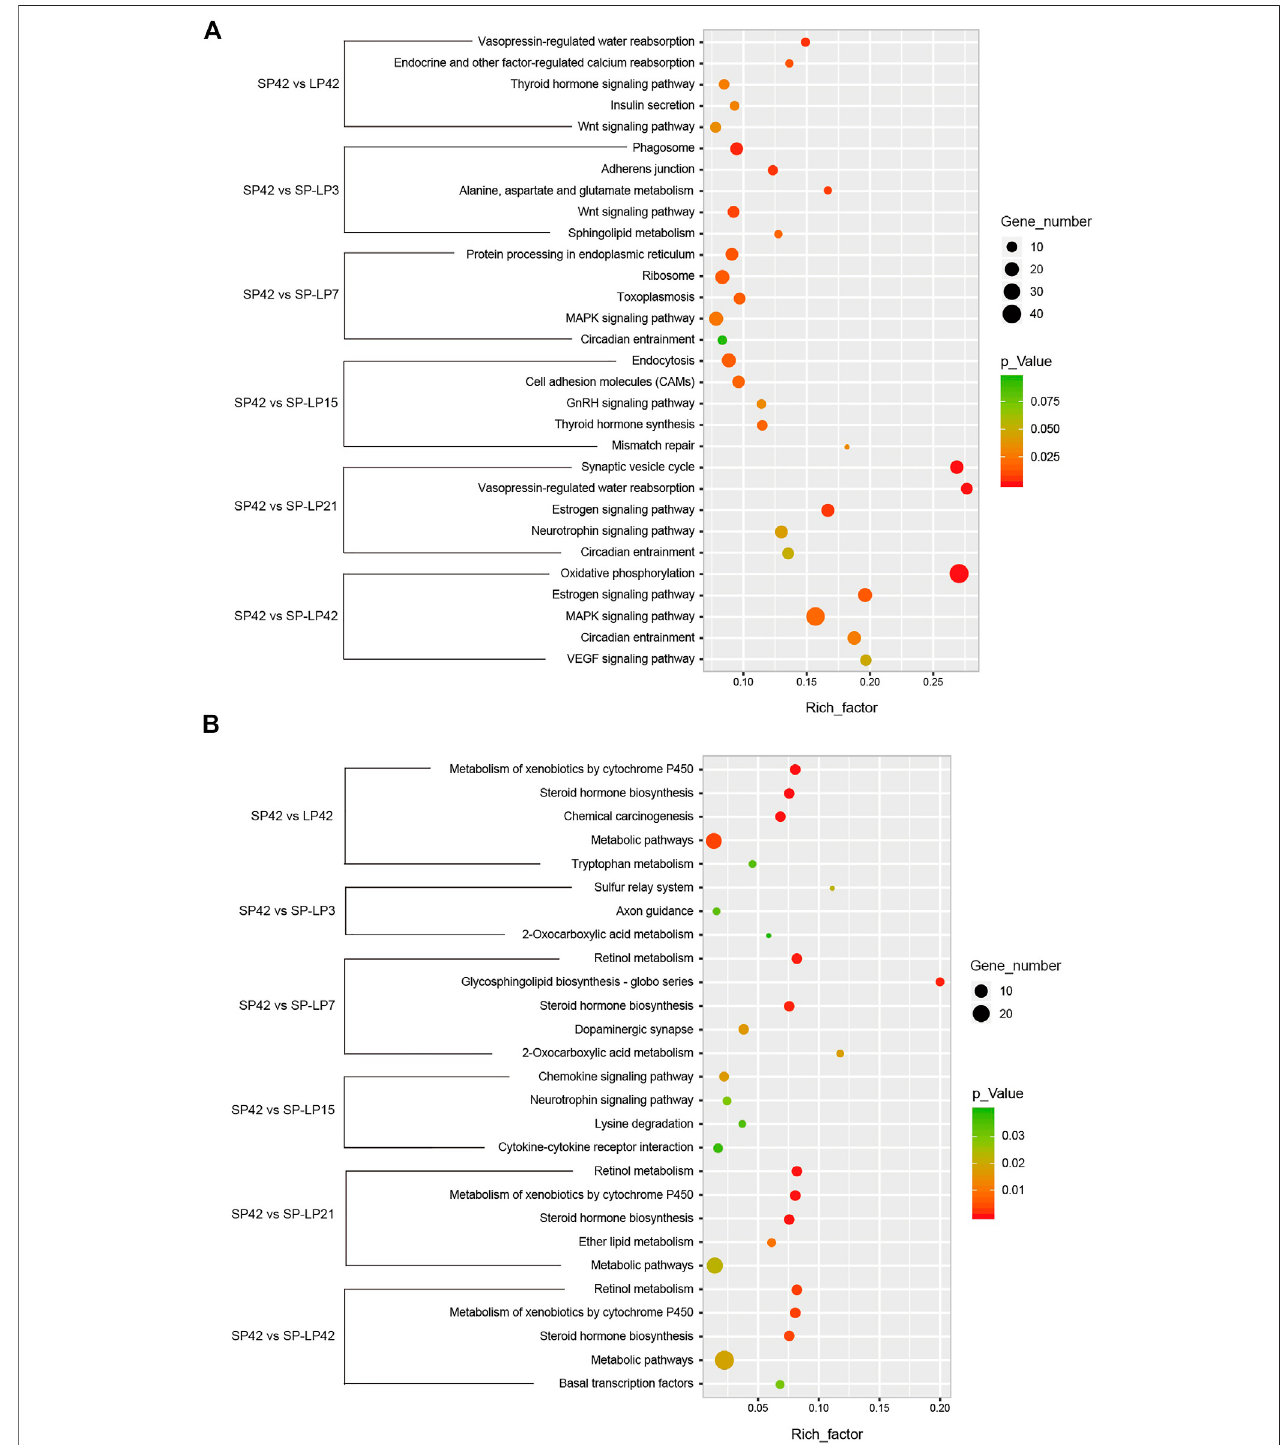
FIGURE 7 | KEGG analysis of differentially expressed mRNAs and lncRNAs targets in hypothalamus about photoperiod responsiveness. (A) Five of the top KEGG enrichment pathway for differentially expressed mRNAs; (B) three to fi ve of the top KEGG enrichment pathway for differentially expressed lncRNA targets. The longitudinal axis represents the enrichment pathways in different compared groups, and the horizontal axis represents the rich factor of these pathways. The spot size and color represent the number of differentially expressed genes and statistical signi fi cance of each pathway, respectively.